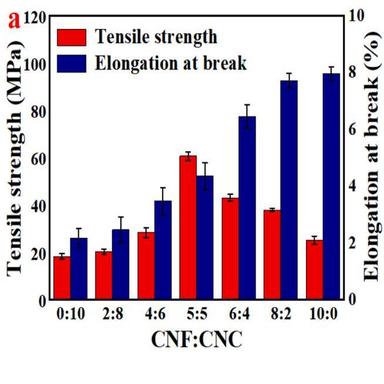
Mechanical properties of nanocomposite films with different ratios of CNF/CNC: (a) Tensile strength and elongation at break, (b) tensile index.